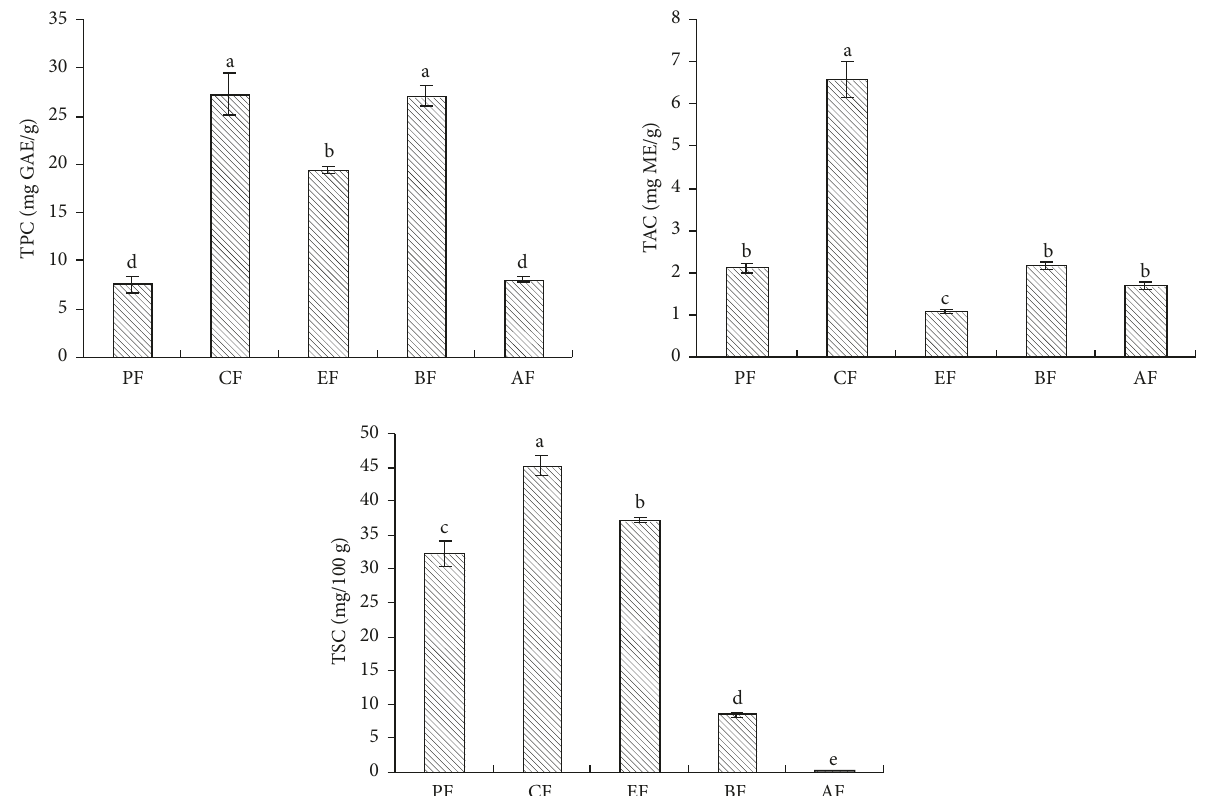
Figure 2: Contents of secondary metabolite of the polarity fractions and hydroalcoholic extracts from maca. The values are means ± standard deviations of triplicate analyses. Columns labeled with different letters are significantly different (𝑃 < 0.01) by Duncan